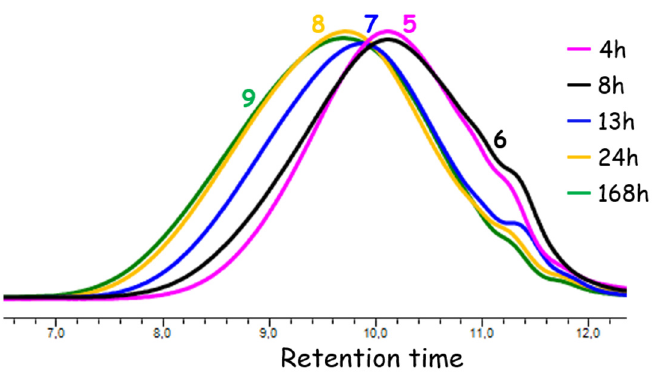
Figure 4. GPC curves obtained in Experiments 5 – 9.